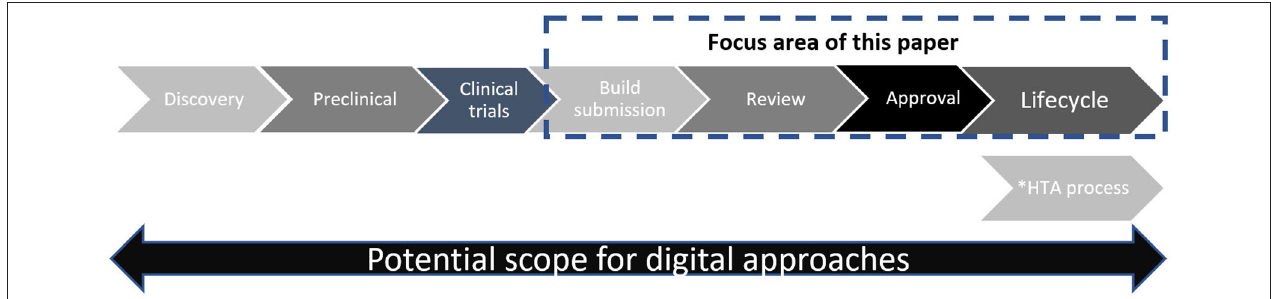
FIGURE 1 | Simplified schematic of drug development and review. *Timing of HTA process varies according to national procedures—in some countries HTA review may start in parallel to regulatory